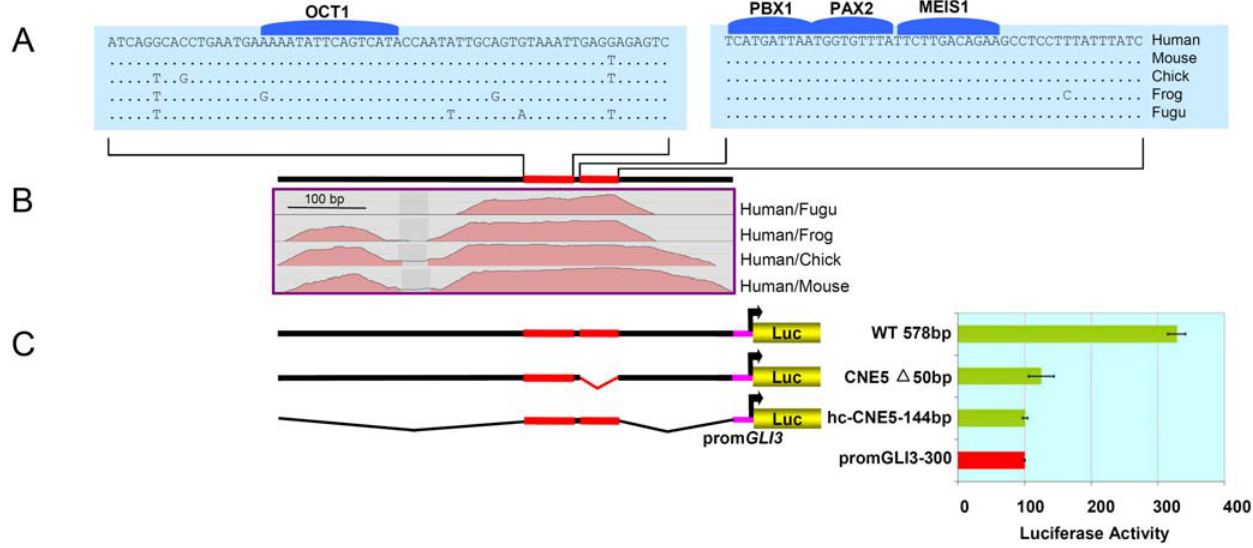
Figure 6. Putative Binding Sites for Individual Trans-Acting Factors are Necessary but not Sufficient for Activating Potential of CNE5. (A) BLASTZ alignment of highly conserved fragments embedded within CNE5 along with predicted conserved TFBSs. (B) CNE5 alignment plot of human, mouse, chick, frog and Fugu sequences using human sequence as the base line. (C) Architecture of wild type and deletion constructs; the red portion of the bar depicts the highly conserved human/fish regions. Luciferase activity obtained in H661cells after transient transfection of reporter constructs is shown in the diagram at the right side. Reporter gene expression is driven by CNE5 fragments upstream of the human GLI3 minimal promoter. The red bar depicts luciferase expression (100%) in H661 cells driven alone by the control GLI3 minimal promoter (Prom GLI3 -300), while the green bars represent the activity recorded for the vectors containing experimental reporter constructs, i.e. wild type CNE5 (wt 578bp), CNE5 with deleted PBX1, PAX2 and MEIS1 binding module ( CNE5 D 50bp ), and the 144 bp fragment ( hcCNE5-144bp ). Deletion of the 50 bp fragment almost entirely extinguishes the strong activating potential of CNE5. The isolated 144 bp fragment cannot activate expression.